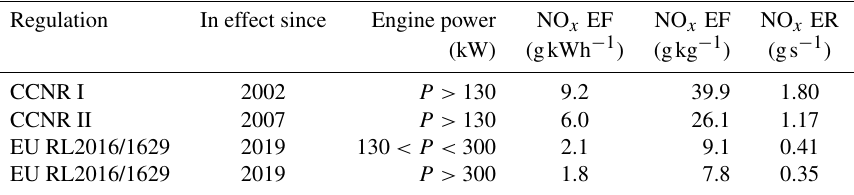
Table 6. Overview of NO x emission limits, according to CCNR (The European Parliament and the European Council, 1998; CCNR, 2020) and EU regulations (given, in both cases, in units of gkWh − 1 ; The European Parliament and the European Council, 2016). For comparison, these have been converted (to gkg − 1 ) using a specific fuel consumption for inland ships of 230gkWh − 1 (De Vlieger et al., 2004) and further converted (eventually to gs − 1 ) using the 162kgh − 1 fuel consumption